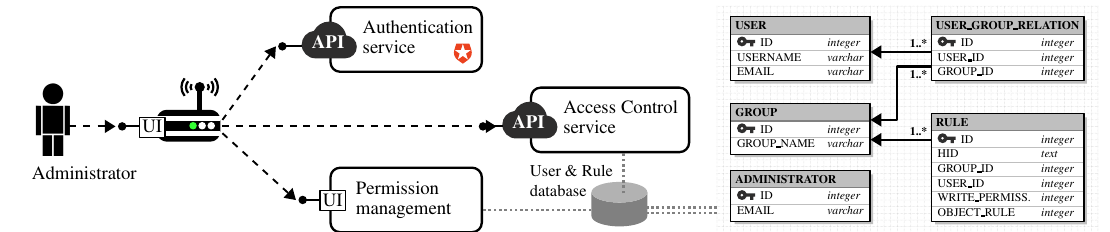
Figure 5. In-depth overview of the security module developed in bIoTope (cf. Case 2 in Figure